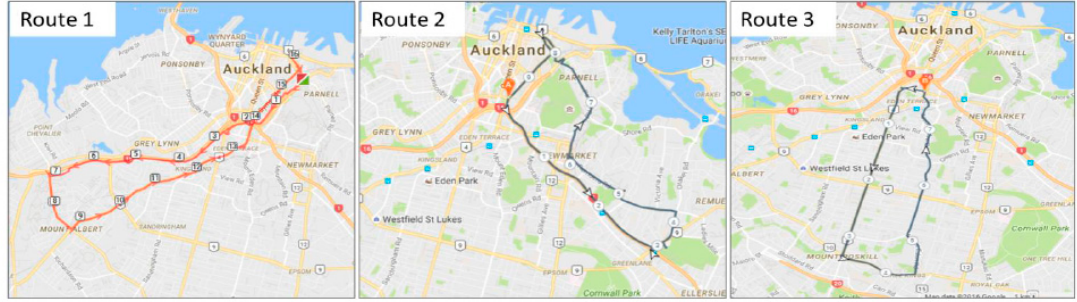
Figure 1. Maps of the three different transit routes across Auckland. Images taken from Google Maps.